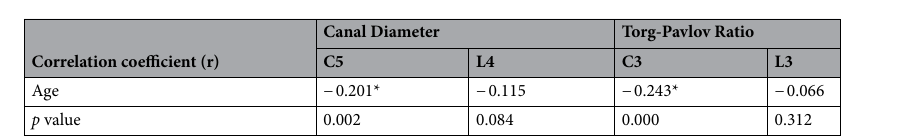
Table 3. Correlations between age and mean canal diameter/canal-body (Torg-Pavlov) ratio. The patients age was inversely correlated with C5 canal diameter and C3 canal-body ratio. * p value < 0.05.